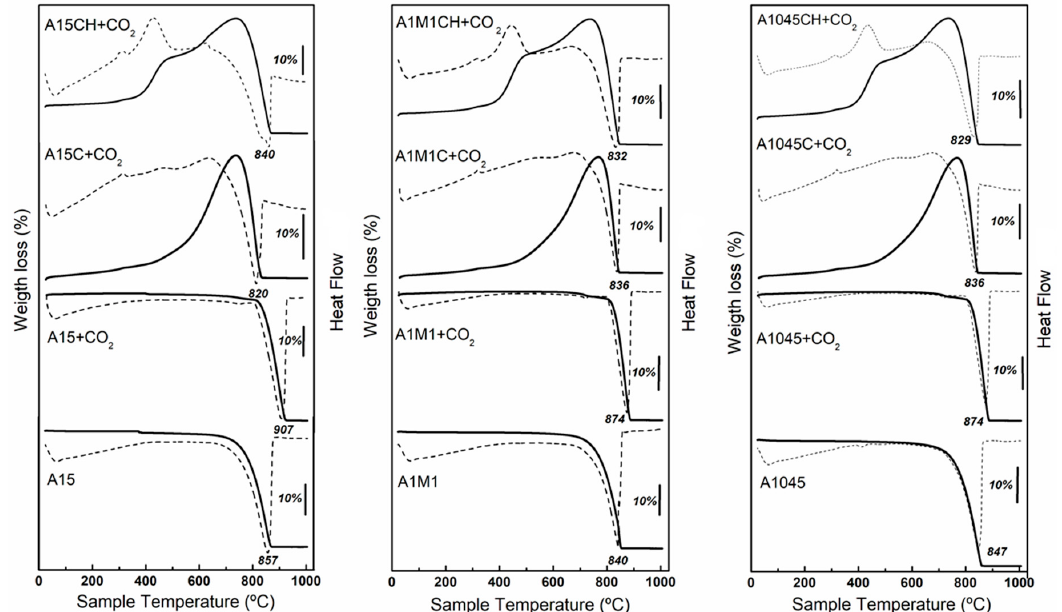
Figure 5. TG (solid lines) and DTA (dotted line) curves: for calcite A15, calcite A15 + CO 2 , calcite calcined A15C + CO 2 and calcite calcined and rehydrated A15CH + CO 2 ; for calcite A1045, calcite A1045 + CO 2 , calcite calcined A1045C + CO 2 and calcite calcined and rehydrated A1045CH + CO 2 ; for calcite A1M1, calcite A1M1 + CO 2 , calcite calcined A1M1C + CO 2 and calcite calcined and rehydrated A1M1CH + CO 2 . Table 2. Gas-solid carbonatation of di ff erent samples under non-isothermal conditions at the same heating rate (5 ◦ C min − 1 ).